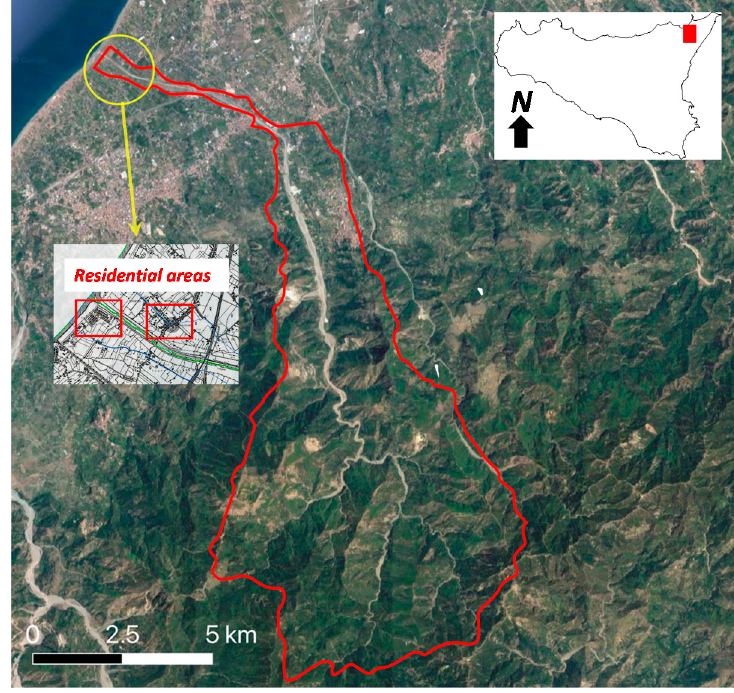
Figure 1. Mela catchment and study area (yellow circle).